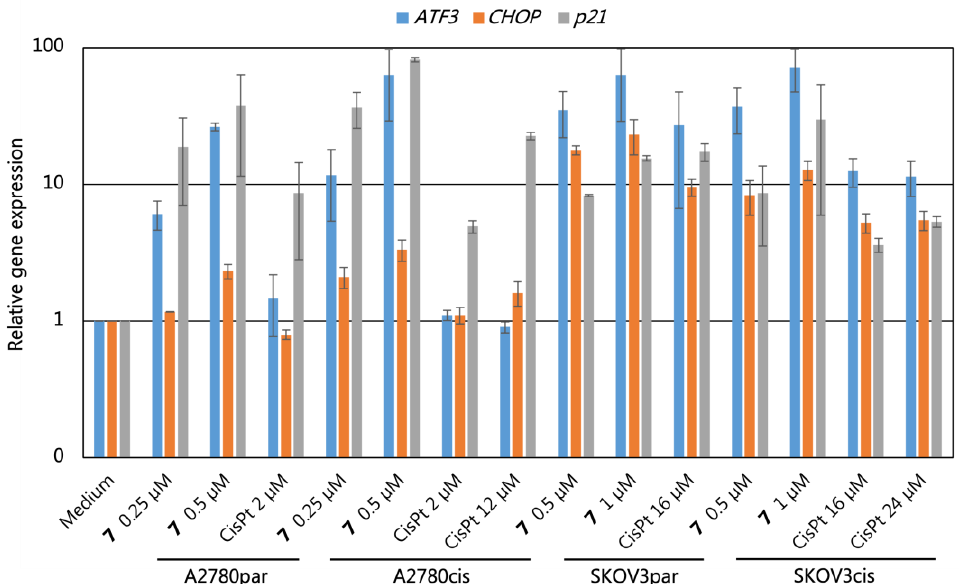
Figure 4. Gene expression analysis for ATF3 , CHOP , and p21 relative to the housekeeping genes glyceraldehyde-3-phosphate dehydrogenase ( GAPDH ) and hypoxanthine phosphoribosyl transferase ( HPRT ) after treatment with complex 7 or cisplatin (CisPt) compared to the untreated control (mean fold change +/ − standard deviation from 2 independent treatments).